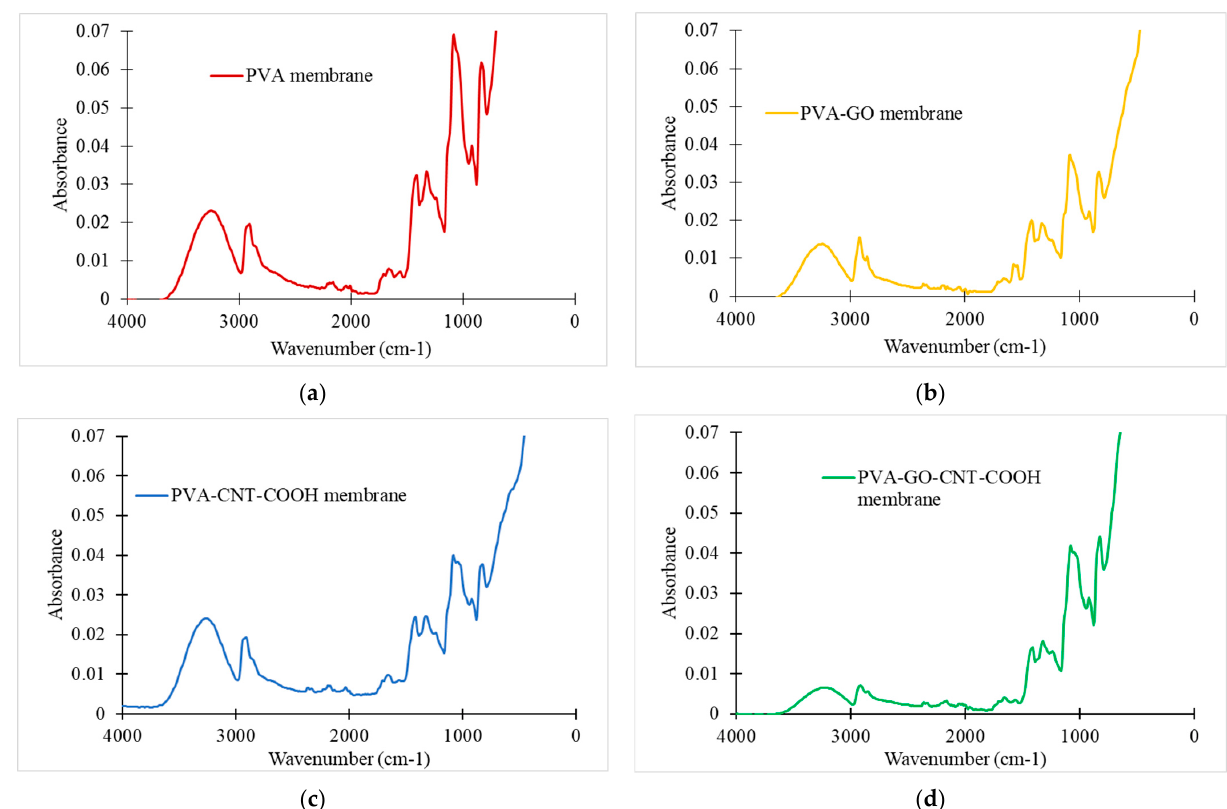
Figure 3. FTIR Analysis of ( a ) PVA; ( b ) PVA_GO; ( c ) PVA_CNT_COOH and ( d ) PVA_GO_CNT_COOH membranes.